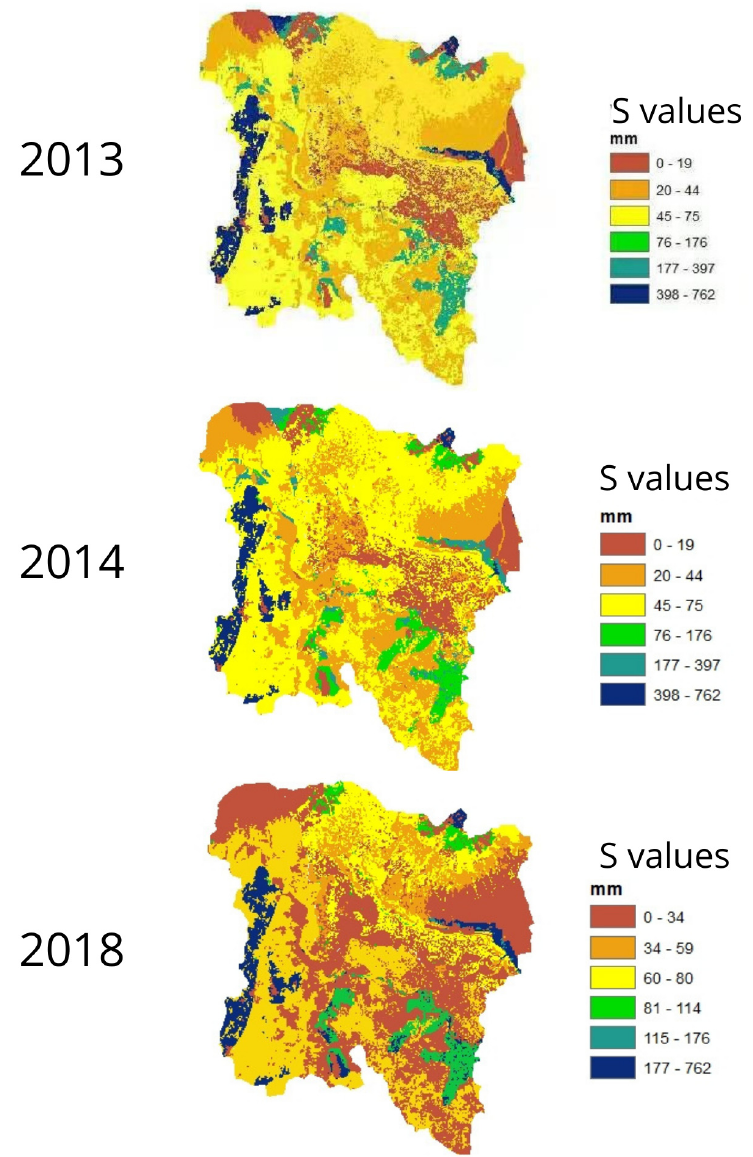
Figure 2. Maps of maximum retention potential of the Chibunga and Guano rivers micro-basins.